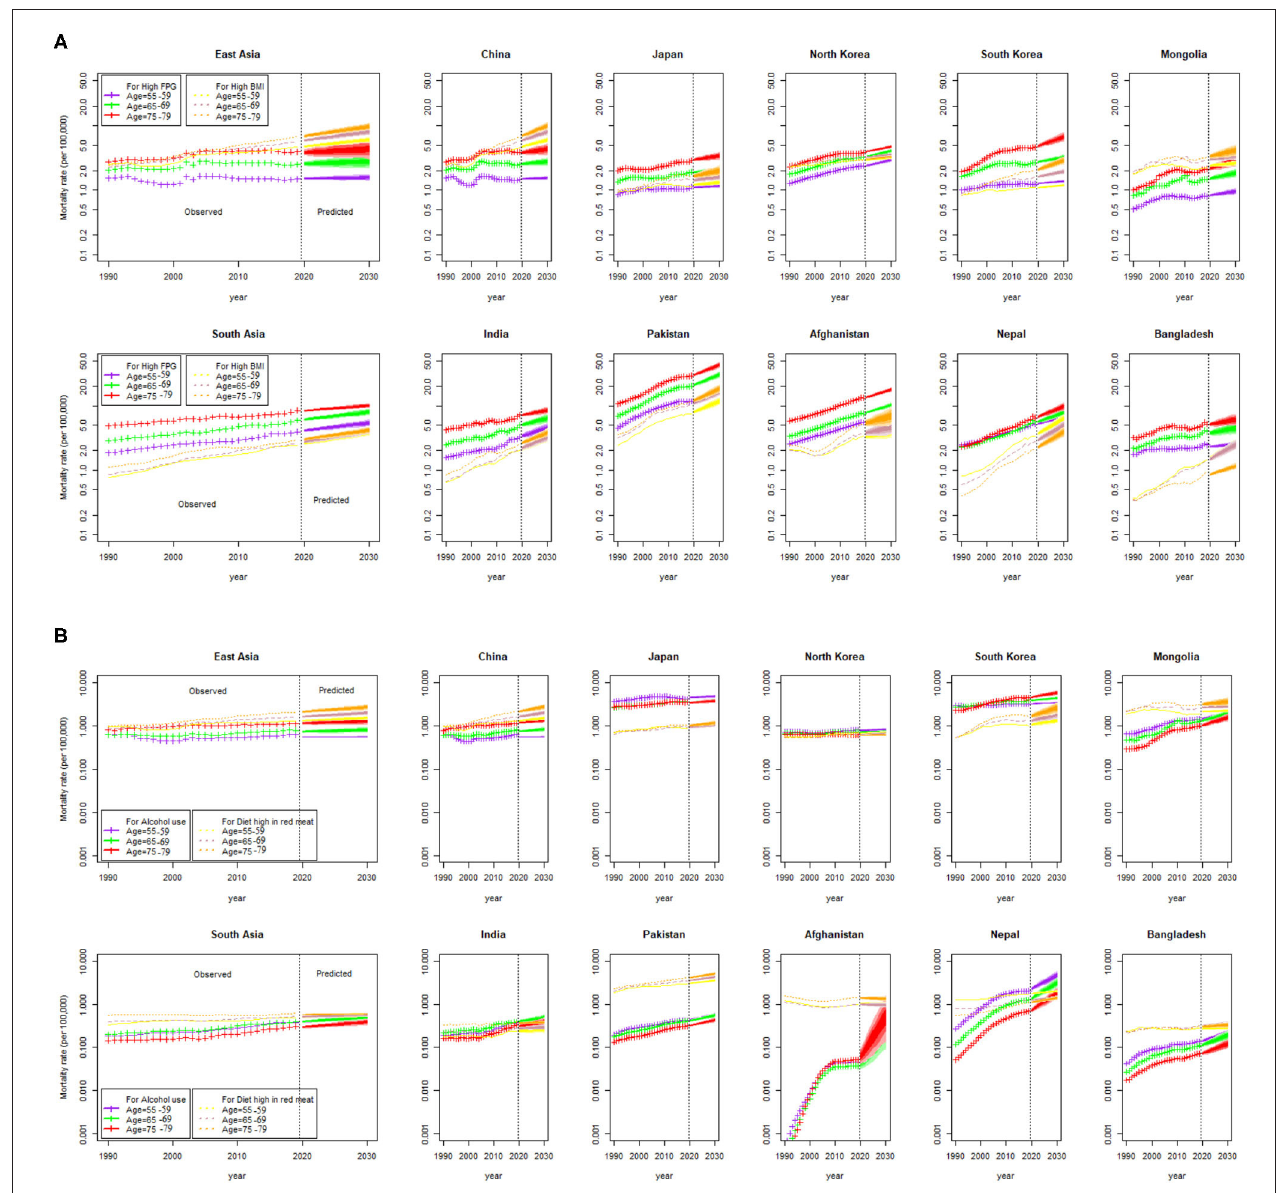
FIGURE 4 | Age-specific risk attributable breast cancer mortality rate (per 100,000) from 1990 to 2030, at a regional and national level. Shades in the fan represent prediction intervals at 80% and 90% level, (A) Predicted mortality rates attributable to high fasting plasma glucose (FPG) and high body mass index (BMI), and (B) Predicted mortality rates attributable to alcohol use and for a diet high in red